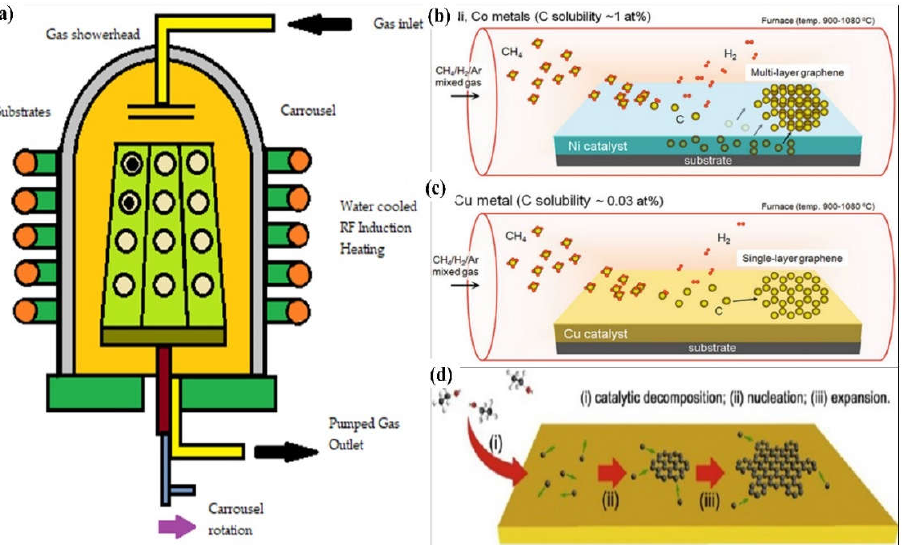
Figure 4. Schematic illustration of ( a ) epitaxial growth systems. CVD growth of graphene sheets on different metals: ( b ) Ni and Co. ( c ) Single-layer graphene growth. Adapted with permission from [32]. Copyright Springer 2015. ( d ) Large-scale CVD growth of graphene on Cu foil. ( i ) catalytic decomposition, ( ii ) nucleation, and ( iii ) expansion. Adapted with permission from [33]. Copyright Elsevier 2015.